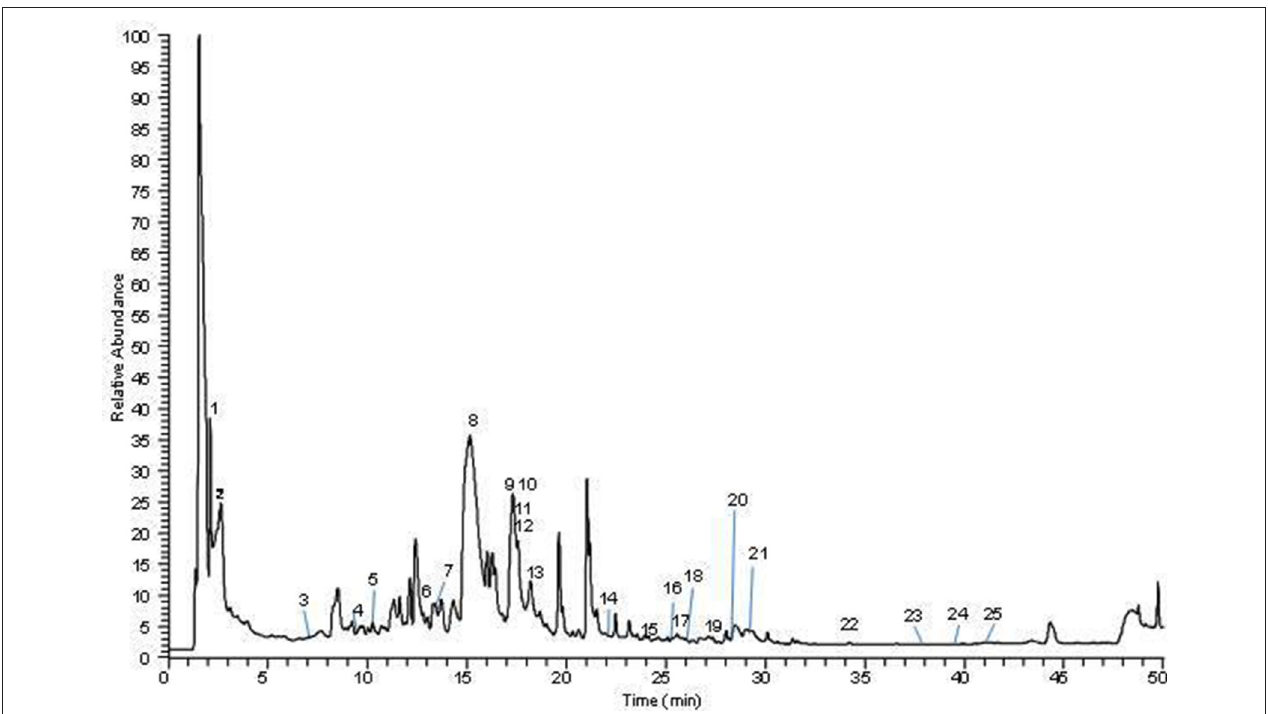
FIGURE 4 | Total ion chromatography (TIC) of the indicated M.calabura sample, obtained with the UHPLC-ESI-MS/MS instrument in negative ion